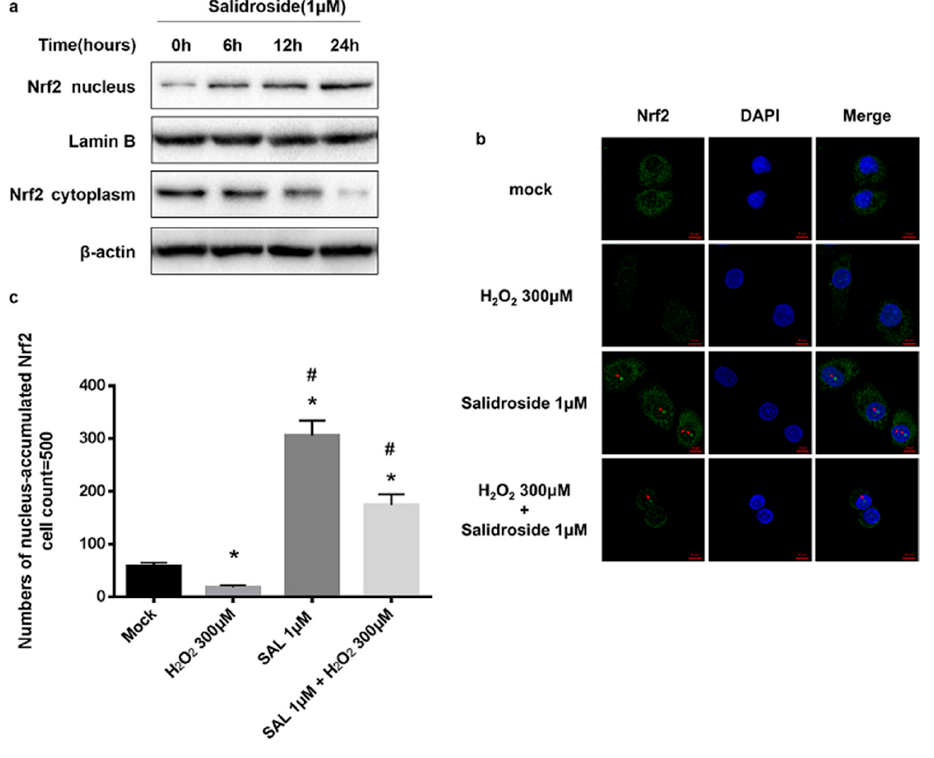
Figure 5. Effects of SAL on Nrf2 nucleus accumulation. ( a ) Time effects of SAL on Nrf2 nuclear translocation. HUVECs were incubated with 1 μ M SAL for 6, 12, 24 h, and nuclear and cytosolic fractions were isolated according the manufacturer’s instruction, as described in the Experimental Section. Protein levels of Nrf2 in nucleus and in cytoplasm were measured by western blotting. ( b ) Immunofluorescence staining of Nrf2. HUVECs were incubated with 1 μ M SAL for 24 h, or 300 μ M H 2 O 2 for 4 h, or 1 μ M SAL for 24 h and 300 μ M H 2 O 2 for a further 4 h. Nrf2 was stained green with Alexa Fluor® 488. The nucleus was stained with DAPI, and the merge represents the combined image of Nrf2 fluorescence and nuclear staining. The same results were obtained in three independent experiments. ( c ) Pooled data of nucleus-accumulated Nrf2. For each group, we counted the numbers of nucleus-accumulated Nrf2 in different visual fields for 500 cells. Data was presented as mean ± SD, n = 500, * p < 0.05 vs. control. # p < 0.05 vs. H 2 O 2 -treated HUVECs.